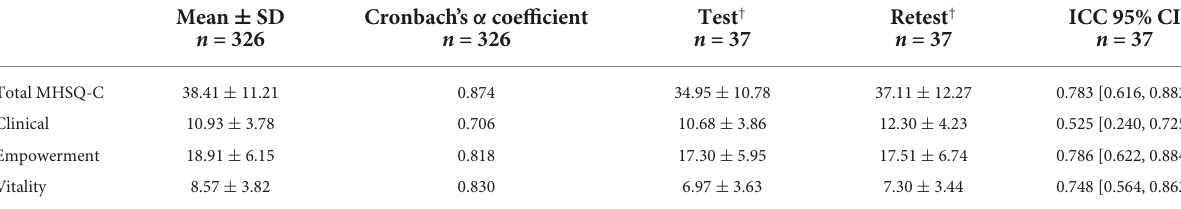
TABLE 3 Internal consistency and test-retest reliability